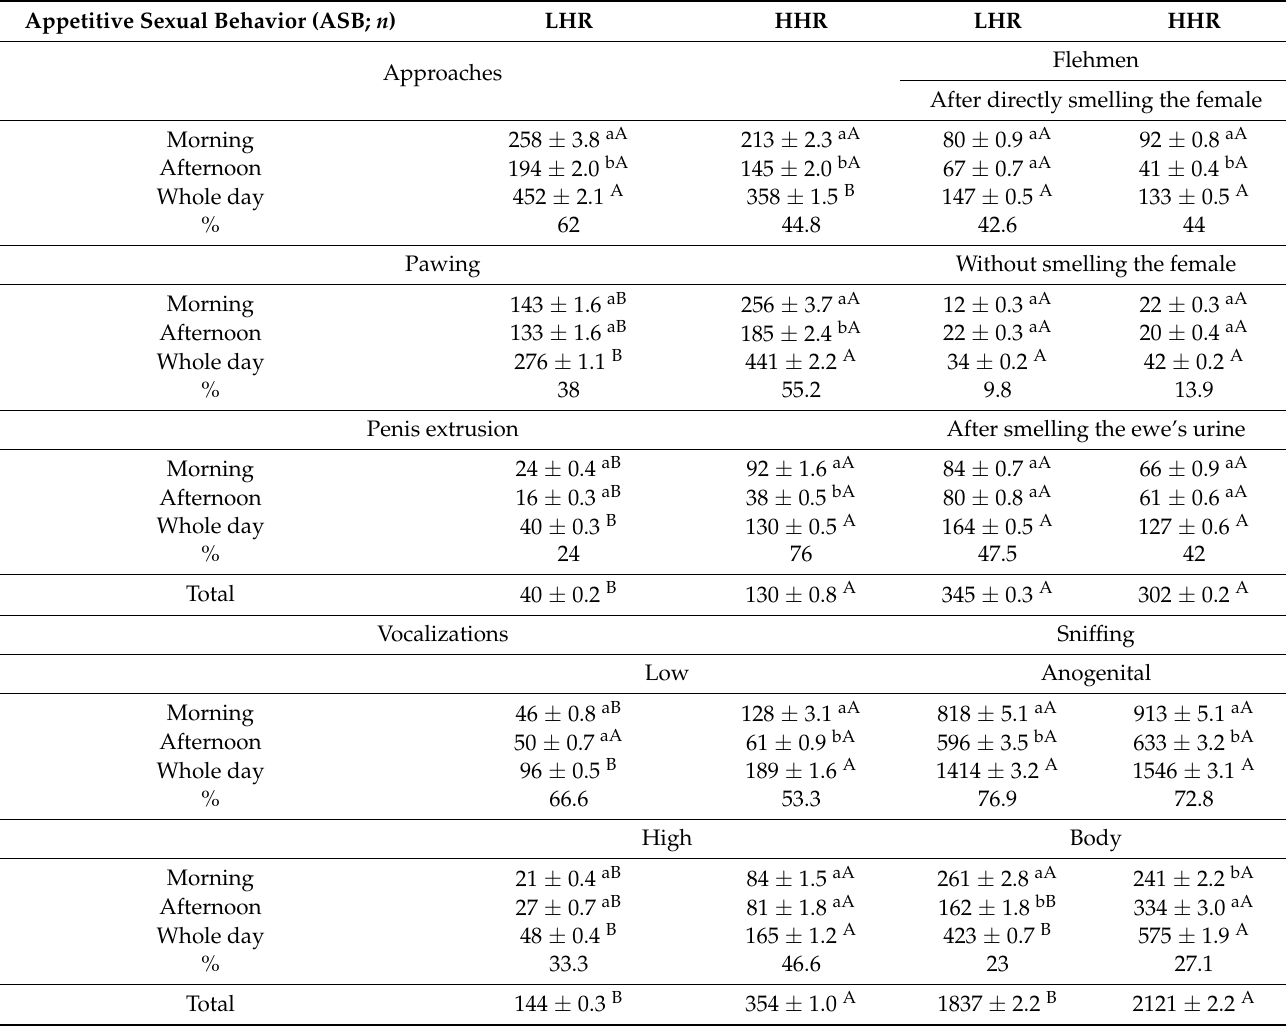
Table 4. Appetitive sexual behavior of adult Dorper rams (ASB) classified as low (LHR) or high hierarchy rams (HHR) during the morning and afternoon.